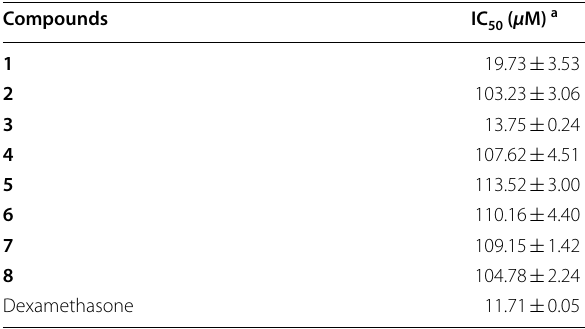
Table 2 Inhibitory activities of compounds 1 – 8 against LPS‑ induced NO production in RAW264.7